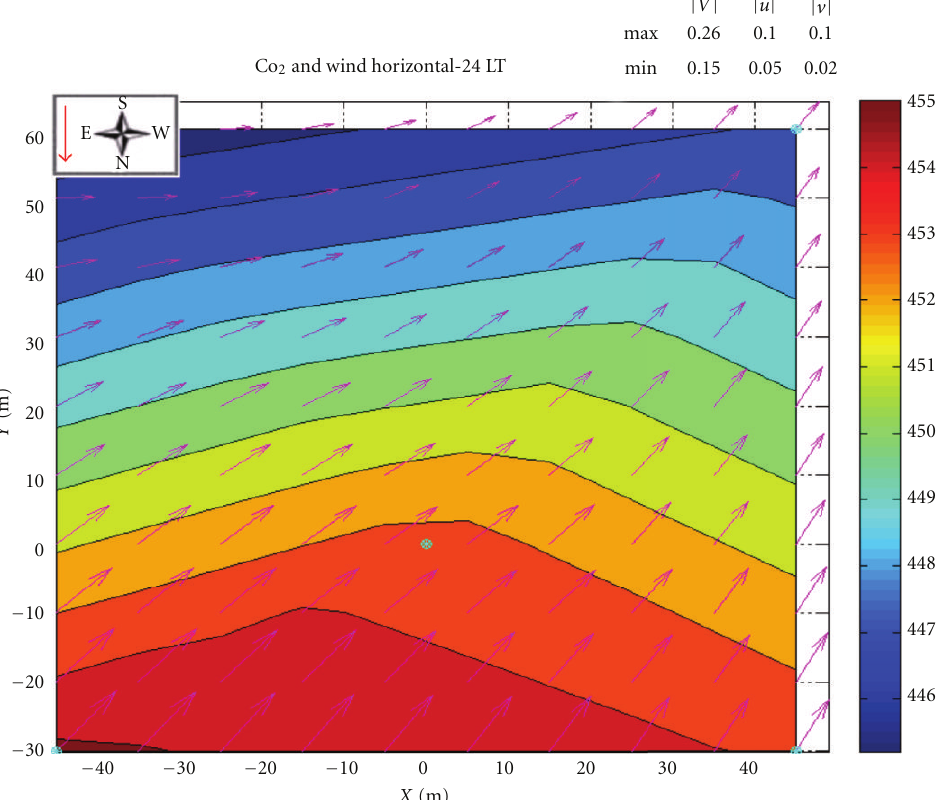
Figure 16: Example at midnight (local time) of the horizontal CO 2 concentration (ppmv) over the DRAINO System south face domain including an interpolated horizontal wind field (10m grid). Note the geographic orientation and the red arrow indicating slope inclination (see Figure